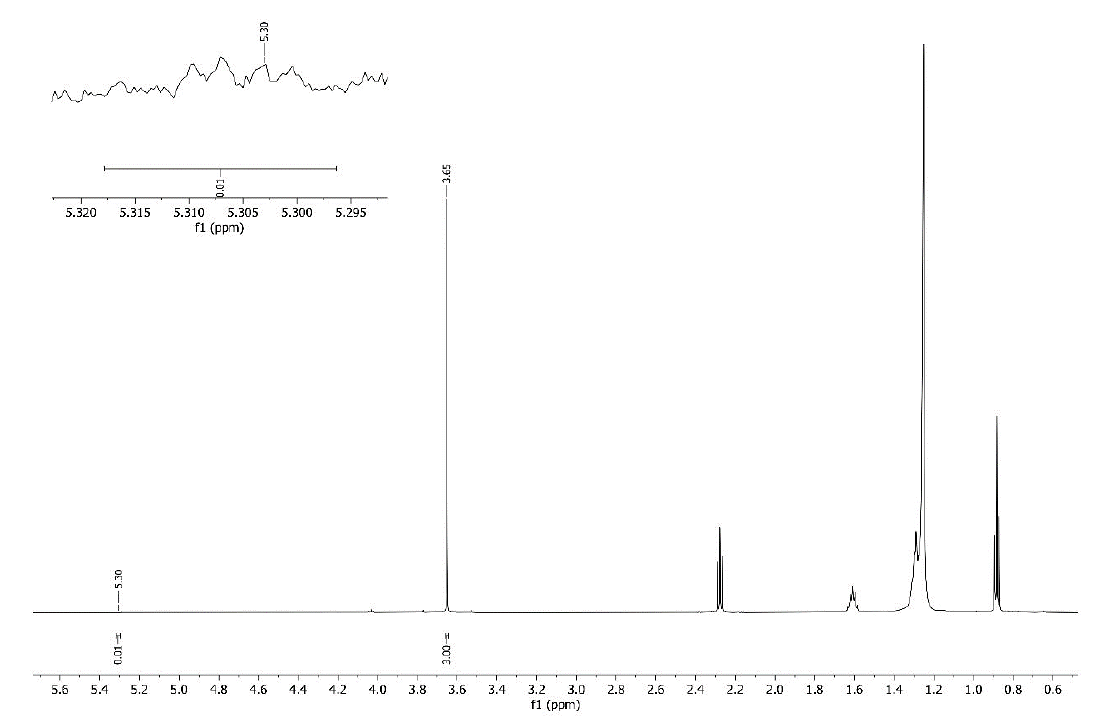
Figure 8. 1 H NMR spectrum for hydrogenated canola